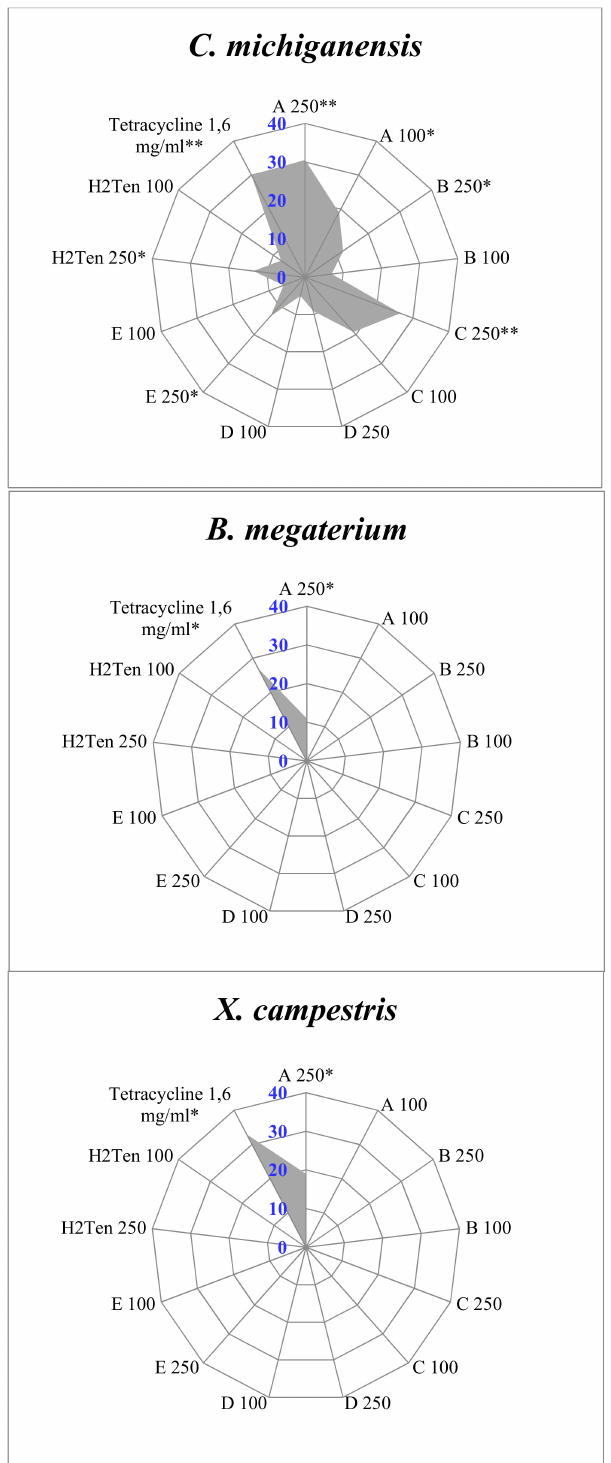
Figure 4. Antimicrobial activity of H 2 Ten and its metal complexes. Where: H 2 Ten: Tenoxicam; A: Manganese complex; B: Cobalt complex; C: Nickel complex; D: Cupper complex; E: Zink complex; Tetracycline: 1.6 mg / mL. Values are recorded as the mean of diameter of inhibition zones (mm) from three replicates ± SDs. (*): statistically significant at P < 0.05: (**): statistically significant at P <